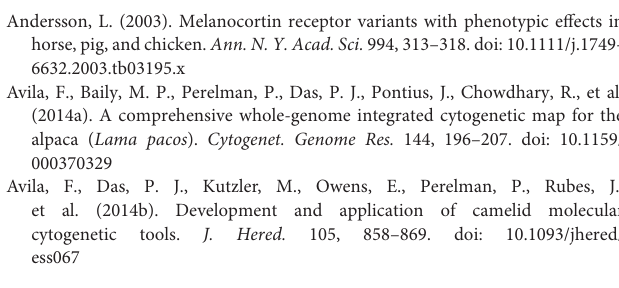
FIGURE S2 | Contingency analysis output files in JMP program for the sequence variants analyzed in this study. Each output file comprises a Mosaic Plot, a Contingency Table, and Statistics Tests; N, the total number of observations; DF, records the degrees of freedom associated with the test; -LogLike, negative log-likelihood; Rsquare (U), shows portion of the total uncertainty attributed to the model fit. ChiSquare, two chi-square statistical tests; Prob > ChiSq, lists the probability of obtaining, by chance alone, a Chi-square value greater than the one computed if no relationship exists between phenotype and genotype. TABLE S1 | Composite information about the dromedaries used in this study (color, ID, country of origin, sex, photo, MC1R g901C > T genotype; ASIP exon 2 g.174495T > Del nonsense mutation, and MC1R 3 (cid:48) UTRG > A genotype); ∗ denote the animals for which genotypes were determined both by Sanger sequencing and TaqMan TM assay. TABLE S2 | Expected and observed allele and genotype frequencies for all variants found in this